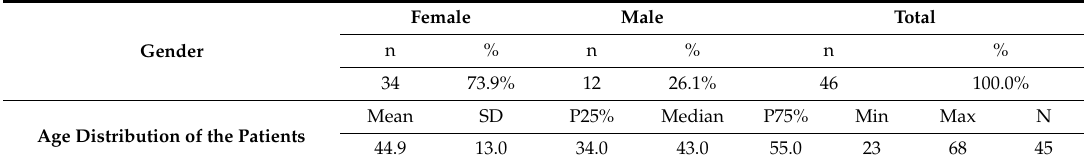
Table 1. Gender and age of the study population. Female Male Gender